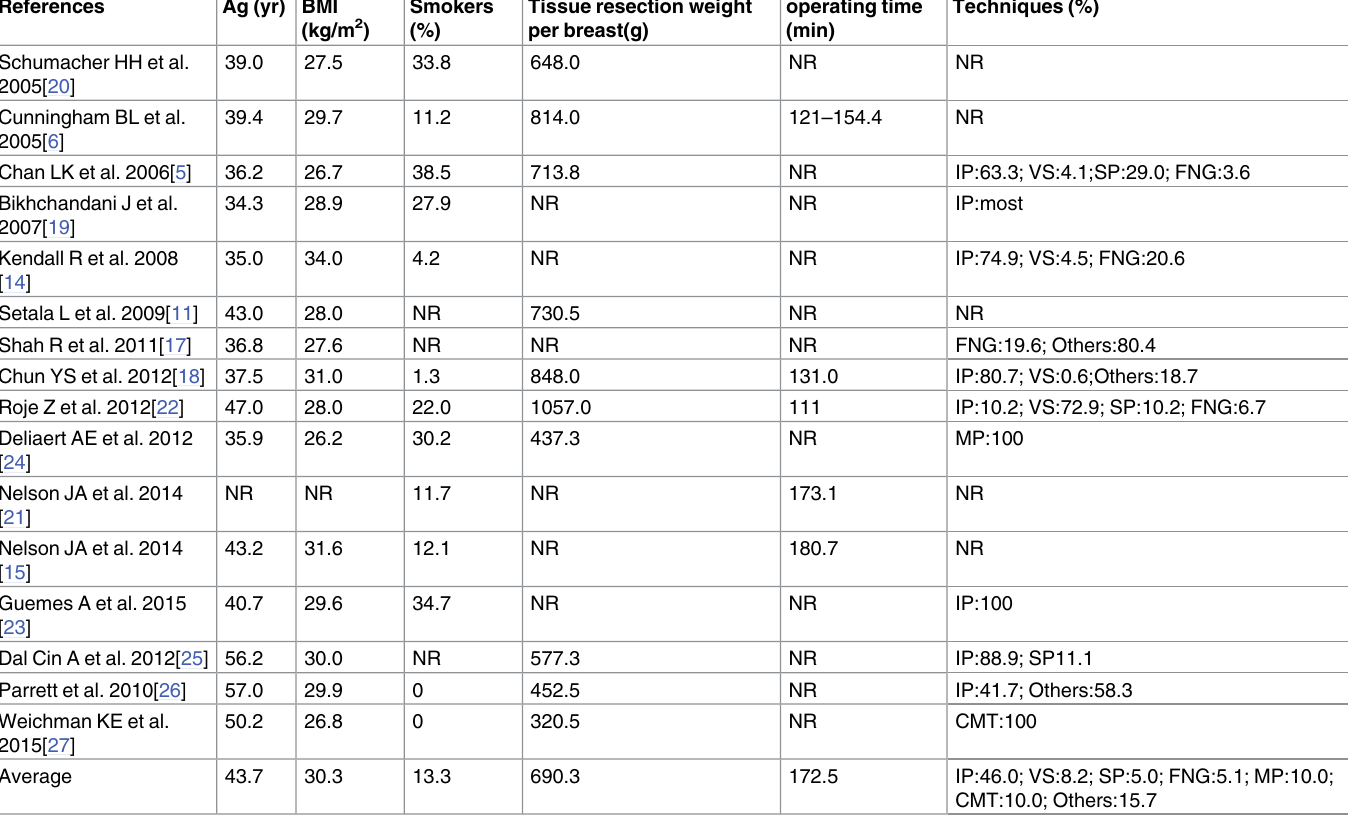
Table 3. Patient and Treatment Characteristics.